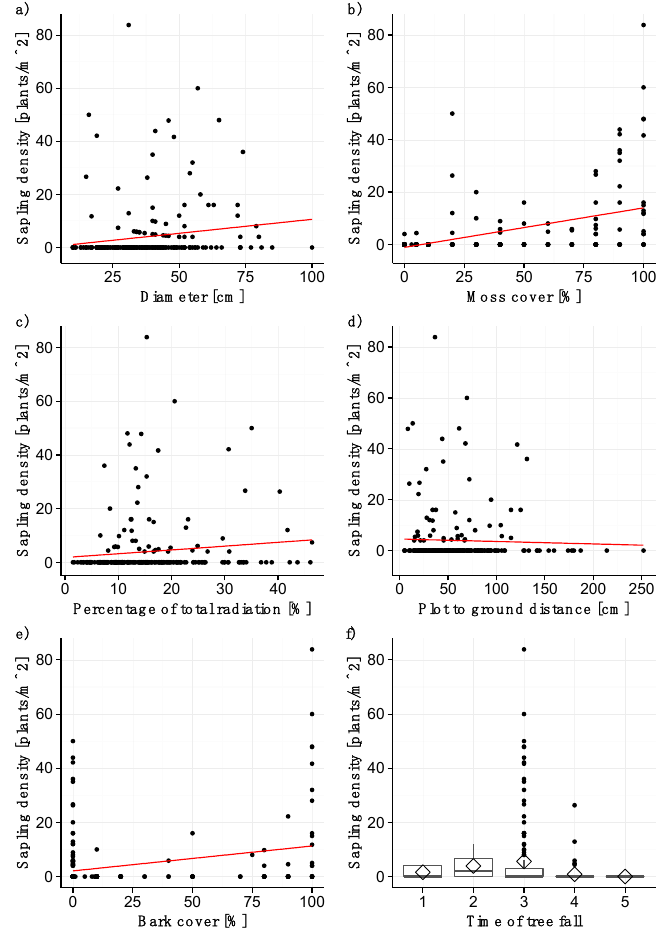
Figure 2. Significant variables for the sapling model: ( a ) diameter of stems, ( b ) moss cover, ( c ) percentage of total radiation, ( d ) distance from plot surface to forest floor, ( e ) bark cover, and ( f ) time of tree fall (1 = before 1965, 2 = 1965–1977, 3= 1977–1989, 4 = 1989–2006, 5 = after 2006). The straight line represents the model fit, the grey shaded area the confidence interval. The rhombuses in ( f ) indicate the mean sapling density.